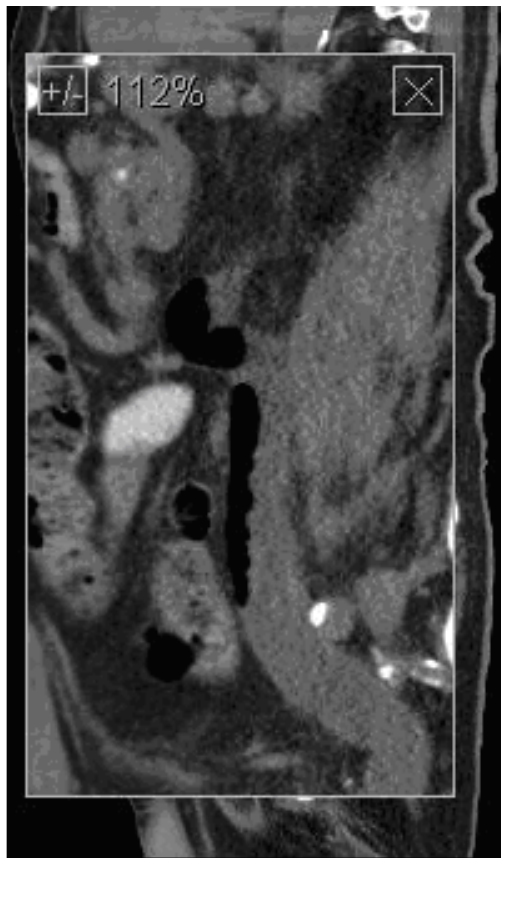
Figure 2 - Axial scan of pelvic CT, (a) noncontrast and (b) contrast enhanced, bone window. A curvilinear hyperdense material (black arrow) was demonstrated at left anterolateral wall of urinary bladder.